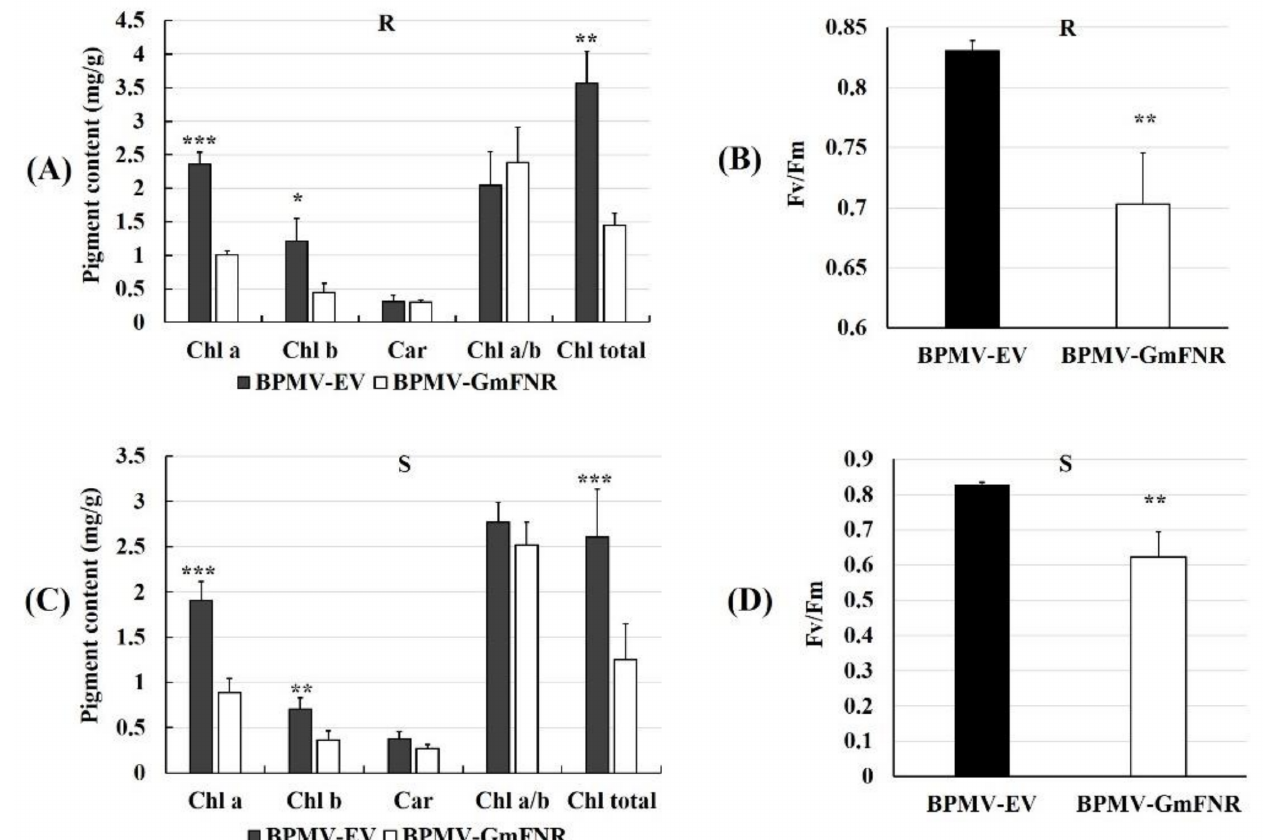
Figure 3. Photo pigments concentration and Fv/Fm in control (BPMV-EV) and silencing (BPMV- GmFNR ) plants of resistant (R) and susceptible (S) lines at 10 days post inoculation (dpi). ( A ) Photo pigments concentration of resistant lines. ( B ) Fv/Fm in resistant lines. ( C ) Photo pigments concentration of susceptible lines. ( D ) Fv/Fm in susceptible lines. Chl a, Chlorophyll a; Chl b, Chlorophyll b; Car, carotenoid; Chl a/b, Chlorophyll a/b; Chl total, total Chlorophyll. “*” indicates the statistical significance at p < 0.05; “**”, p < 0.01; “***”, p < 0.001, t